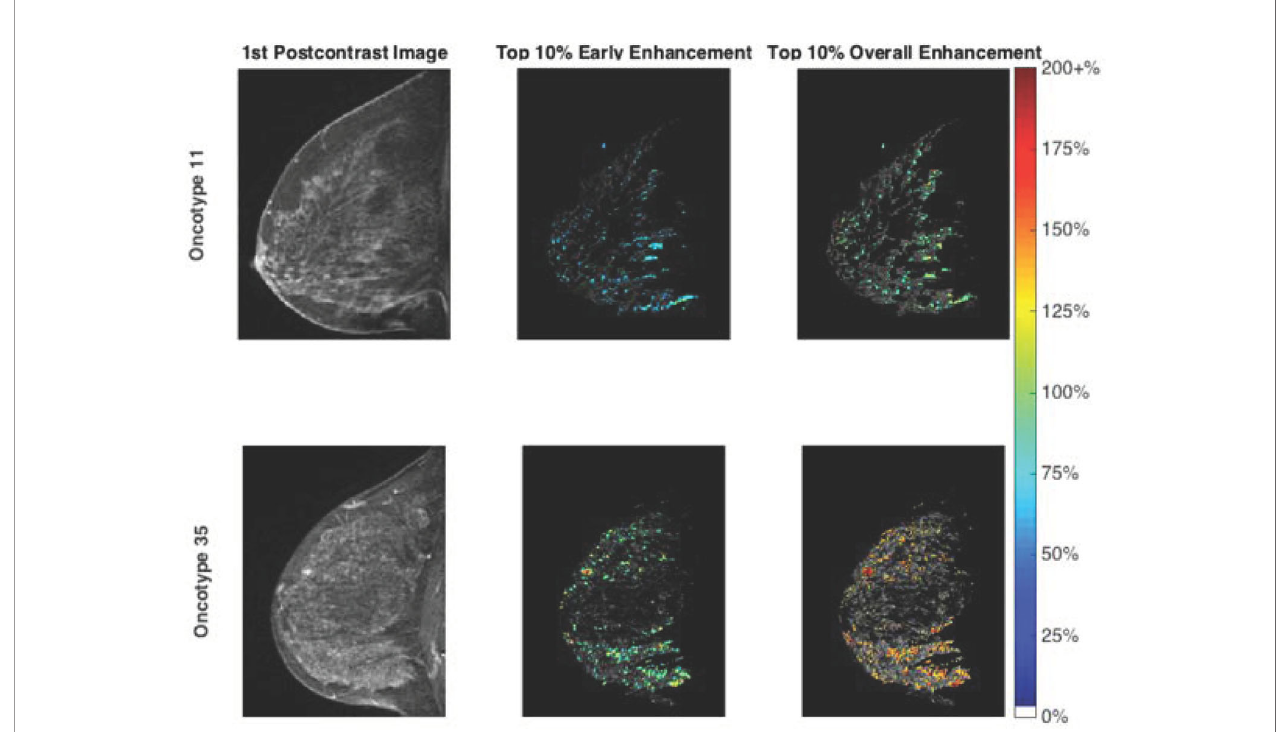
FIGURE 1 | Fibroglandular tissue enhancement in a low risk group patient (top row) and a high risk group patient (bottom row). The fi rst postcontrast images are illustrated (left) alongside segmented fi broglandular tissue with early enhancement overlay (middle) and overall enhancement overlay (right). Note the higher enhancement values evident for the high risk group patient. Oncotype Dx is a prognostic and predictive surrogate for tumor aggressiveness and treatment response. A Oncotype Dx score of 11 is a representative example of a patient that is a low risk. Oncotype Dx score of 35 is a representative example of a patient that is at intermediate/high risk. The “ top 10% ” corresponds to the voxels exhibiting the 10% highest enhancement level in the middle and right fi